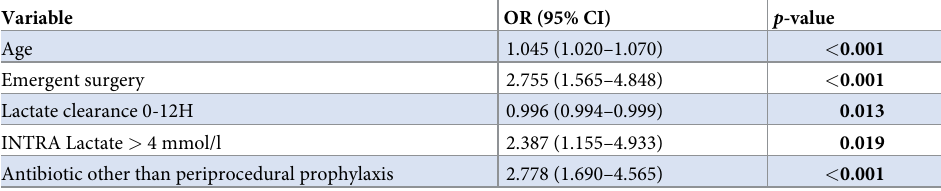
Table 4. Multivariate logistic regression for risk of Clostridioides difficile